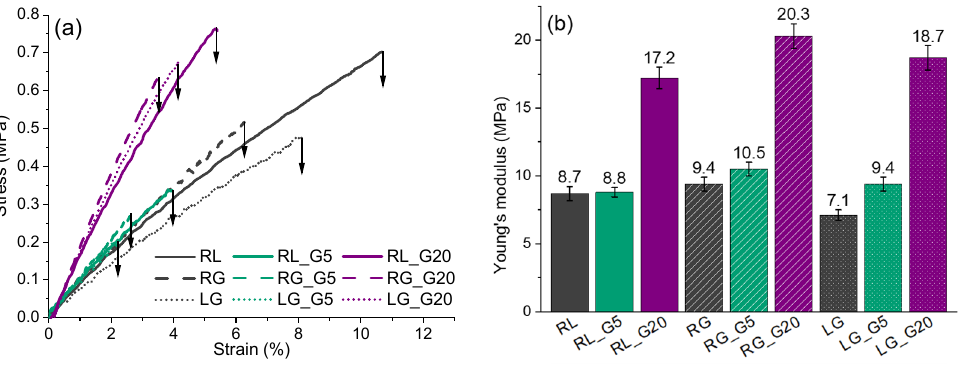
Figure 5. Tensile strength of vegetable oil-based coatings; ( a ) stress–strain curves; ( b ) Young’s mod- ulus.